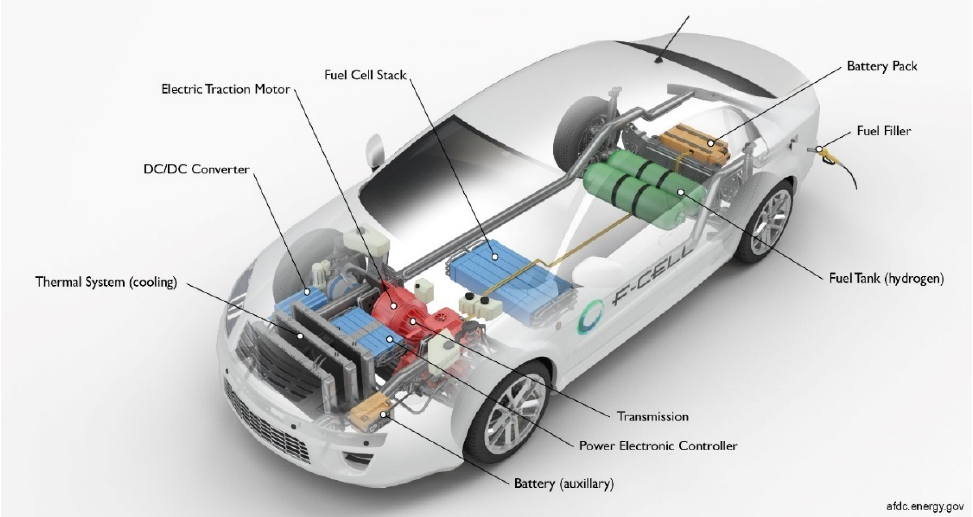
Figure 1. The distribution of the components on the car chassis (see [3], NREL).